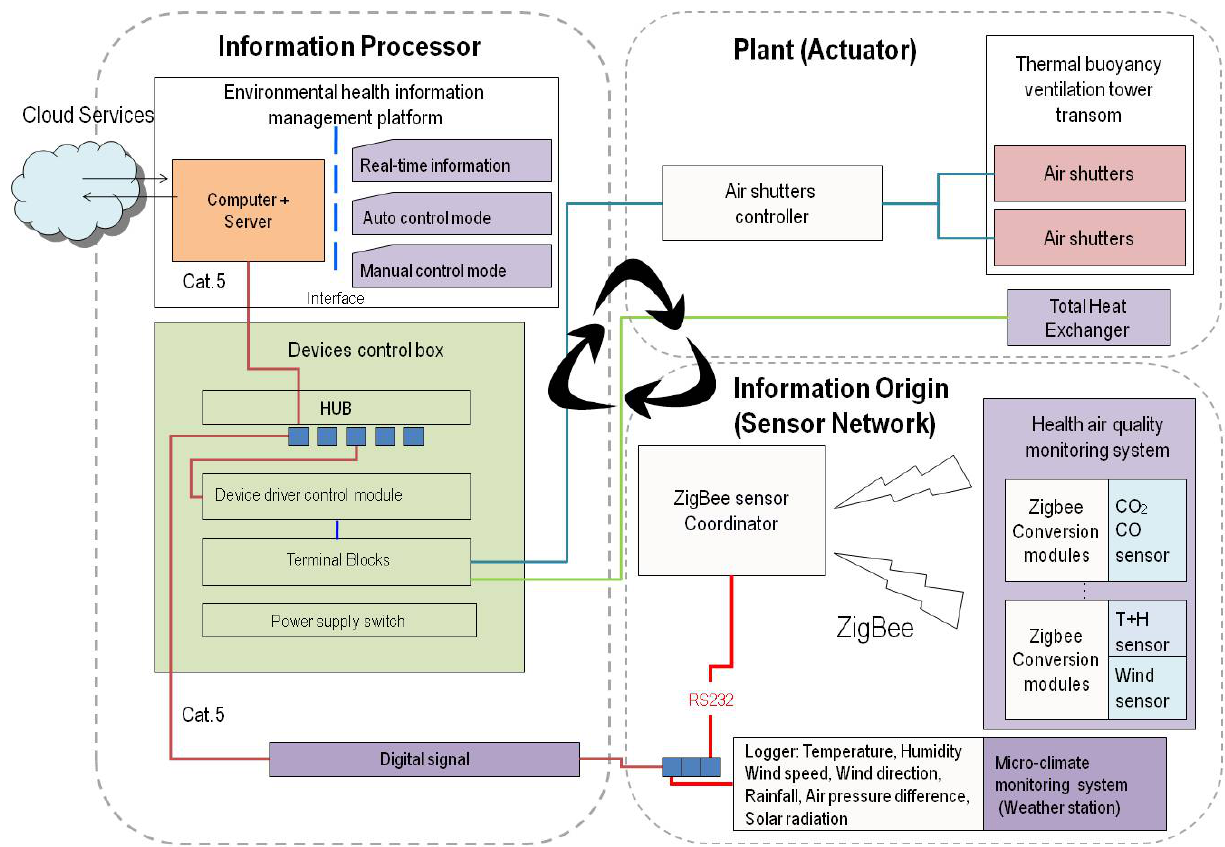
Figure 5. Flowchart of the S House’s building environmental control